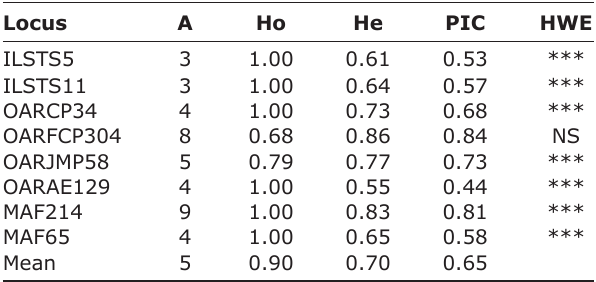
Table-2: Number of alleles (A), observed Ho, expected He, PIC, and HWE for each of the eight microsatellites. Locus A Ho He PIC HWE ILSTS5